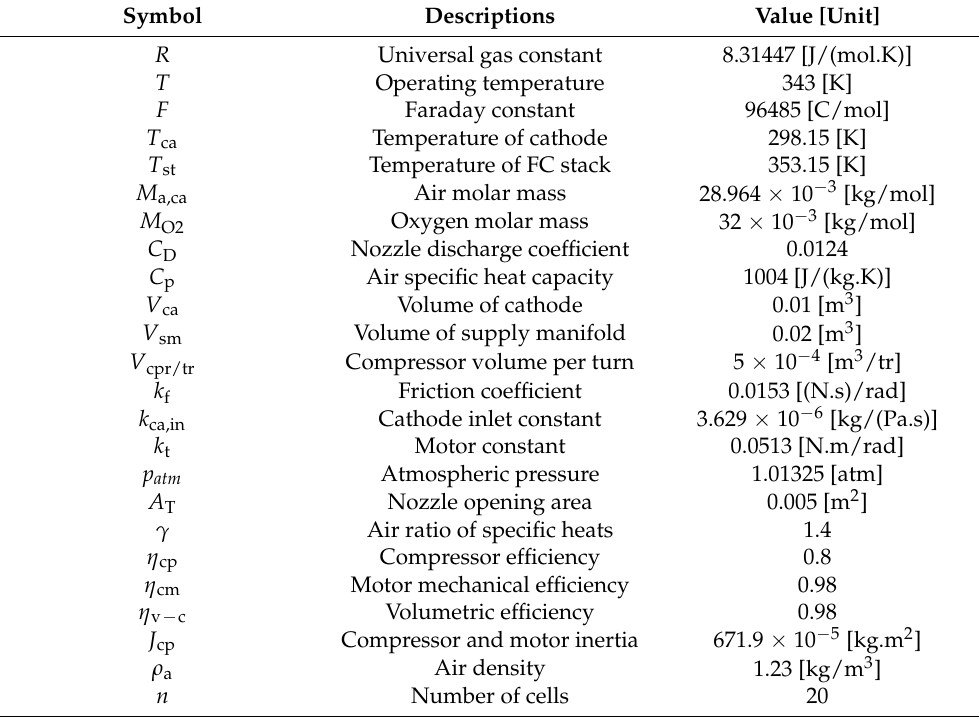
Table 1. H100 PEMFC